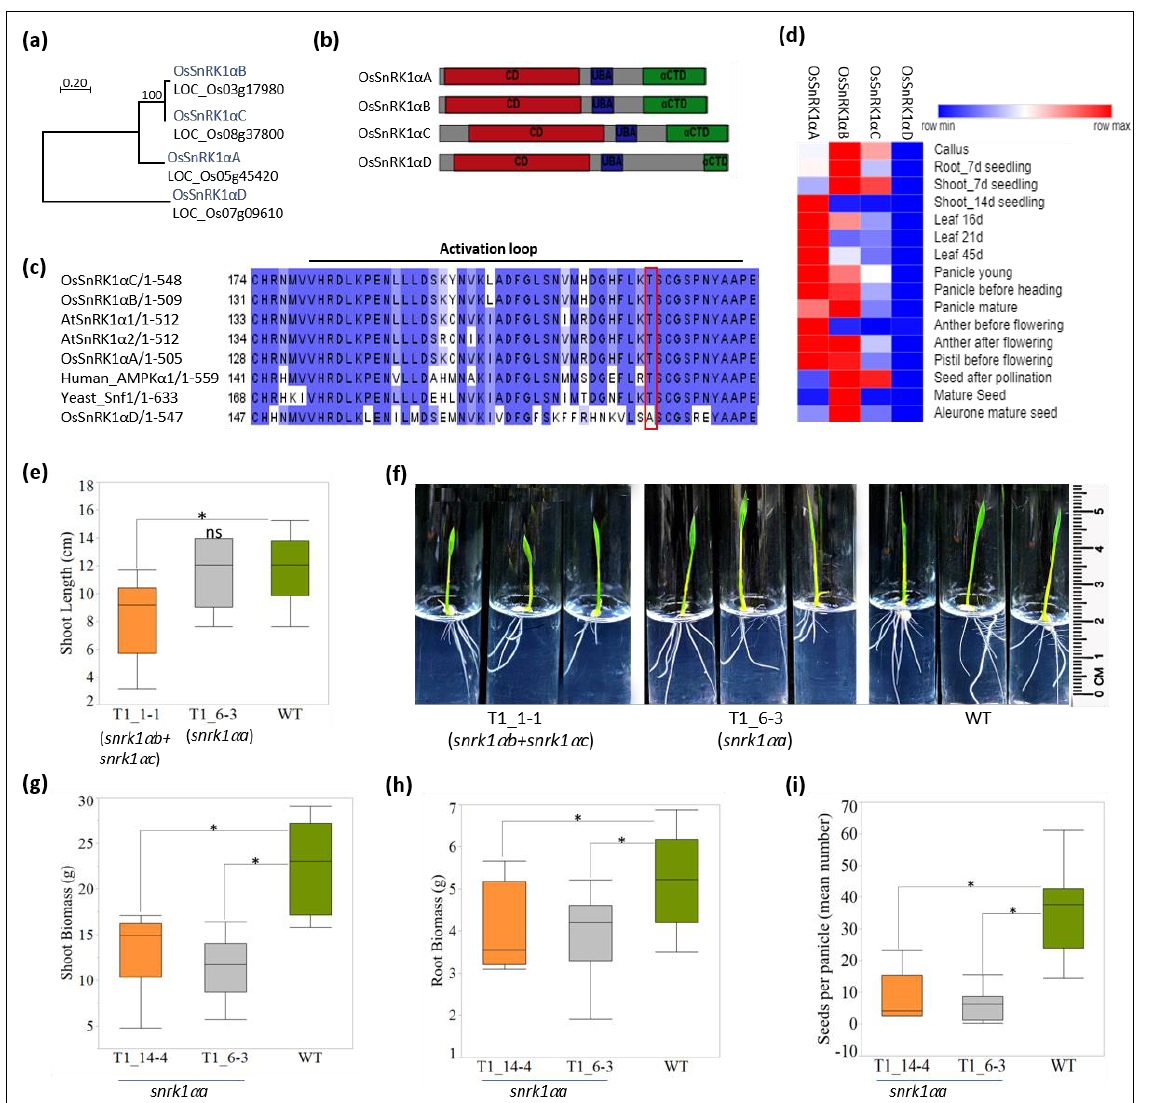
Figure 2. Targeting of OsSnRK1 kinase subunits ( α -subunits) genes. ( a ) Neighbor joining-based phylogenetic reconstruction of rice SnRK1α subunits. ( b ) Domain organization of rice SnRK1α subunits. The domain organization was analyzed by CDD v3.19. CD: catalytic domain; UBA: ubiquitin-associated domain; α CTD: α C-terminal domain. ( c ) Sequence alignment of rice SnRK1 α subunits with Arabidopsis, yeast and human homologs. The sequences were aligned with ClustalX2 and visualized in Jalview (v2.11.2.0). ( d ) Expression level (FPKM) of rice SnRK1α subunits in different tissue and developmental stages. The expression data were retrieved from Rice Expression Database [31]. ( e – f ) Seedling length of 7-d-old snrk1 α double or single mutants and the WT grown in MS½ media ( e ) and representative images of the same ( f ). ( g – i ) Shoot biomass, root biomass, and mean number of seeds per panicle in snrk1 α a mutant lines in comparison to WT. Statistical differences ( p < 0.05, n = 10) by Tukey–Kramer test (HSD) are shown as significant (*) or non-significant (ns). Next, OsSnRK1 α A was targeted at two sites by pNS73. The resulting 40 T0 lines were analyzed by PCR and amplicon sequencing. PCR across the two target sites in a subset of these lines at a young vegetative stage indicated the presence of somatic